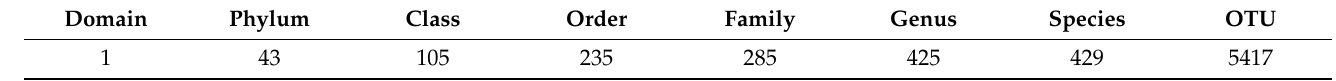
Table 2. Taxonomic information of the total rhizosphere bacterial species.